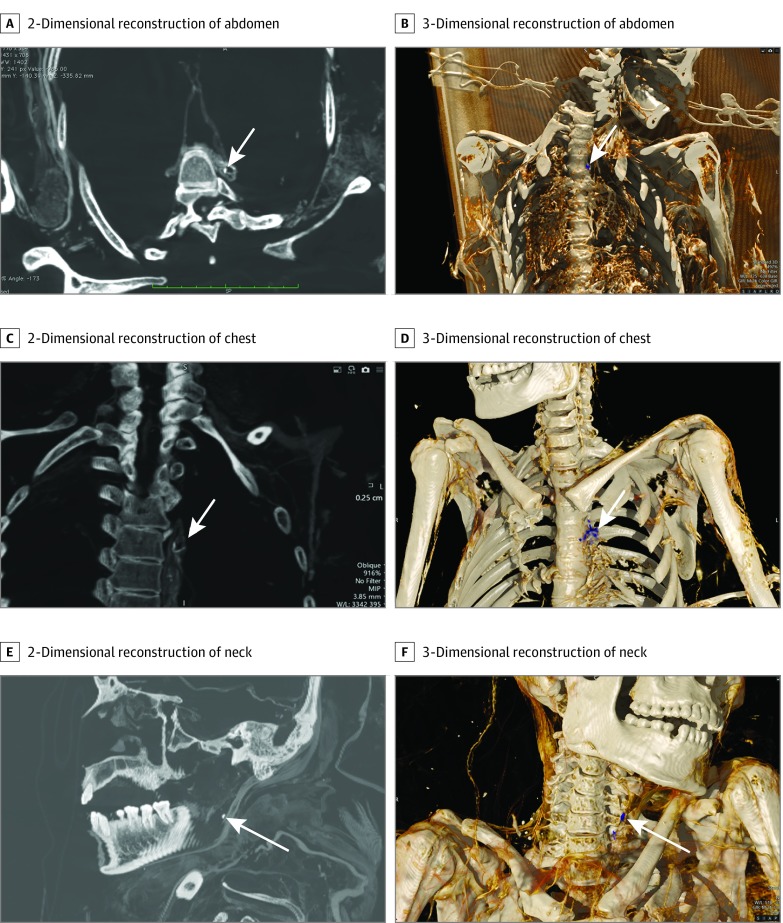
Computed Tomography Images Showing Calcified Atherosclerotic PlaquesArrows indicate calcified atherosclerotic plaques.